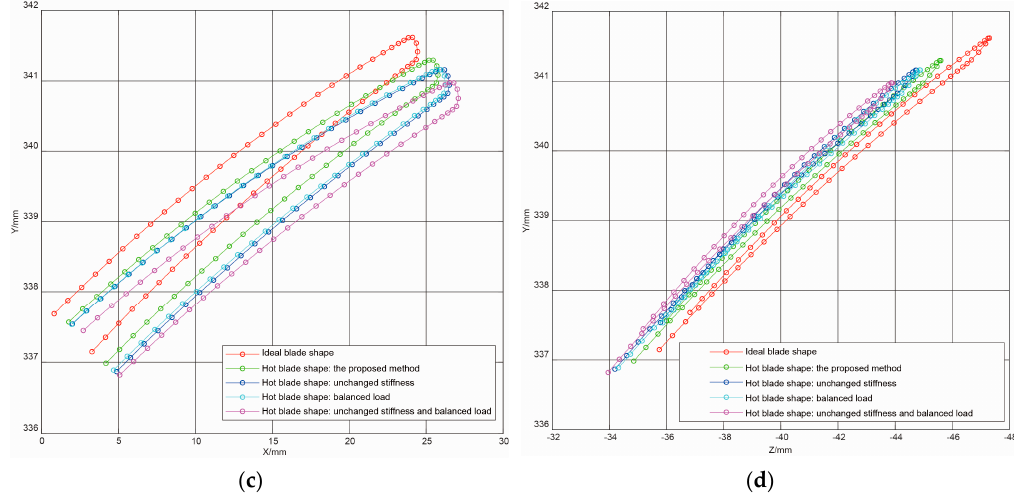
Figure 8. Deviations of the nodes at the trailing edge of the blade top. ( a ) Spatial location of nodes; ( b ) projection in XZ plane; ( c ) projection in XY plane; ( d ) projection in YZ plane.